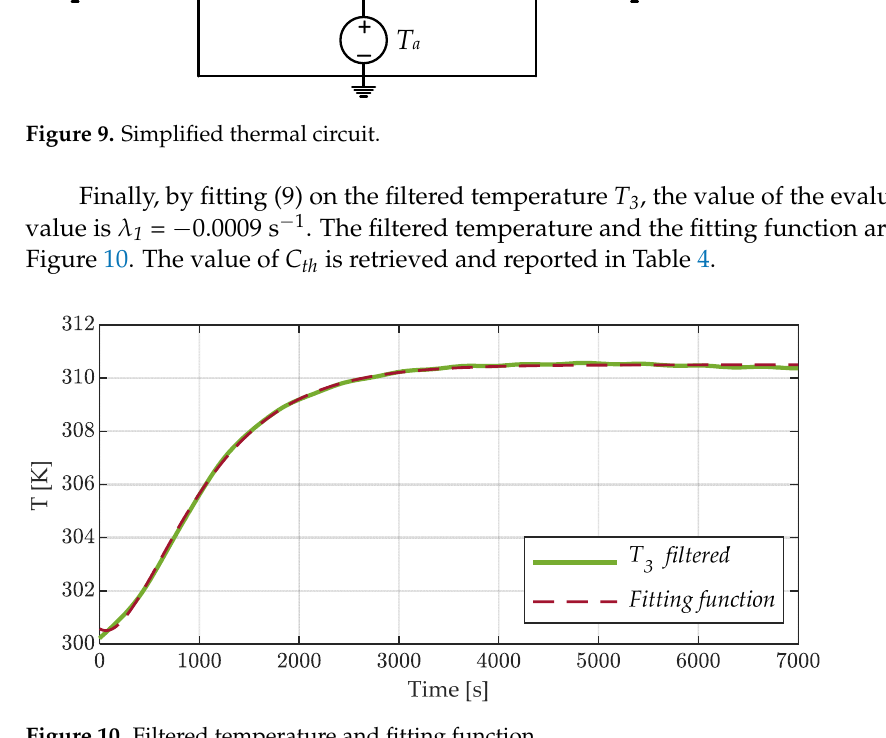
Figure 10. Filtered temperature and fitting function.